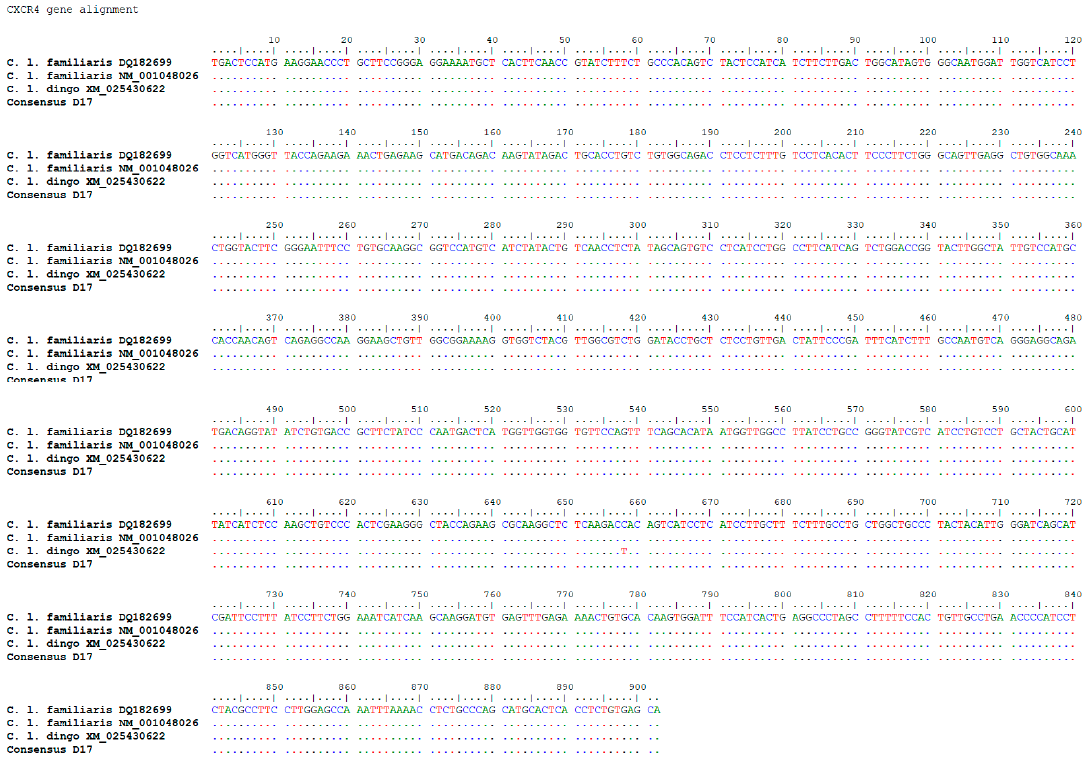
Figure 6. Sequencing of CXCR4 gene: alignment between the obtained sequence and reference sequences: DQ182699.1 Canis familiaris chemokine (C-X-C motif) receptor 4 (CXCR4) mRNA, complete cds; NM_001048026.1 Canis lupus familiaris C-X-C motif chemokine receptor 4 (CXCR4), mRNA; XM_025430622.1 PREDICTED: Canis lupus dingo C-X-C motif chemokine receptor 4 (CXCR4),